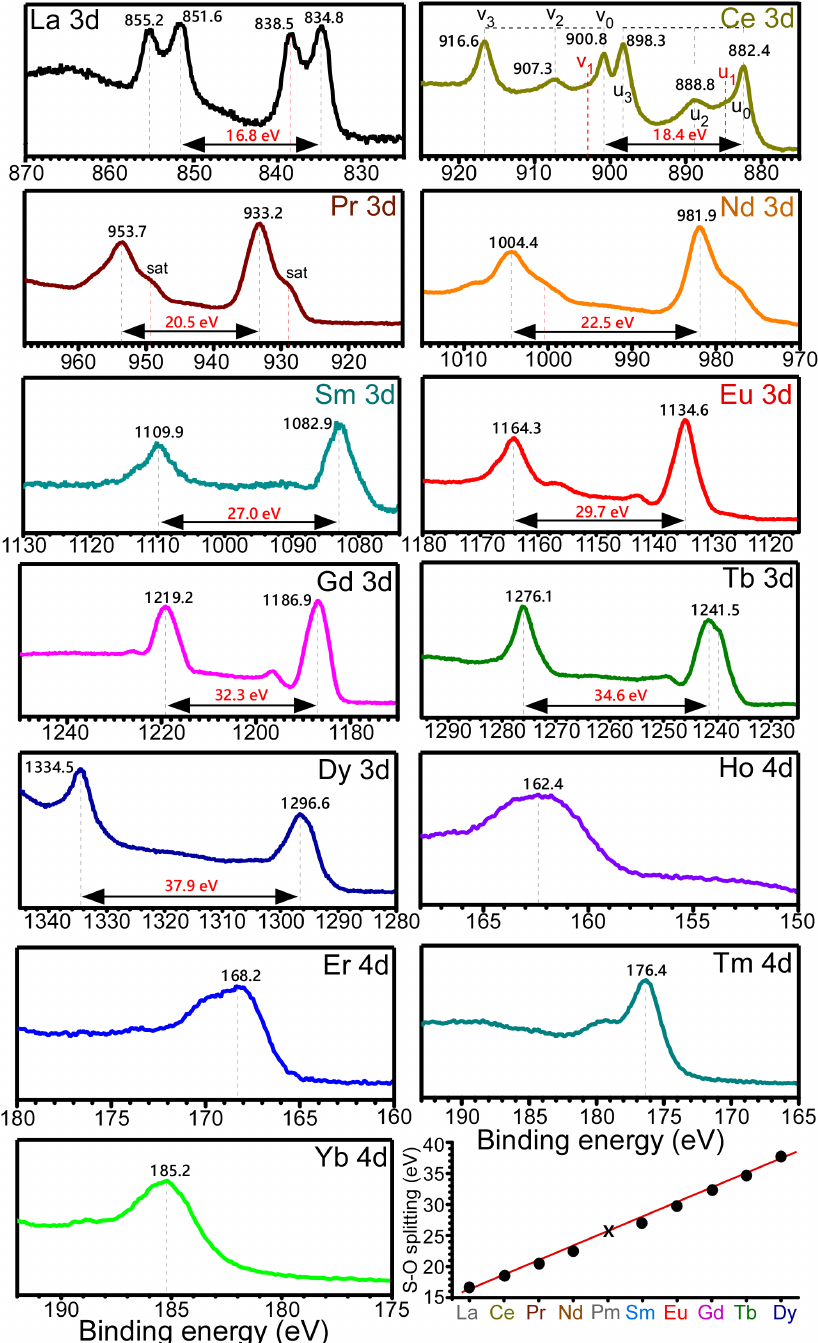
Figure 5. La 3d, Ce 3d, Pr 3d, Nd 3d, Sm 3d, Eu 3d, Gd 3d, Tb 3d, Dy 3d, Ho 4d, Er 4d, Tm 4d, and Yb 4d XPS profiles, and the 3d 5/2,3/2 spin-orbit splitting